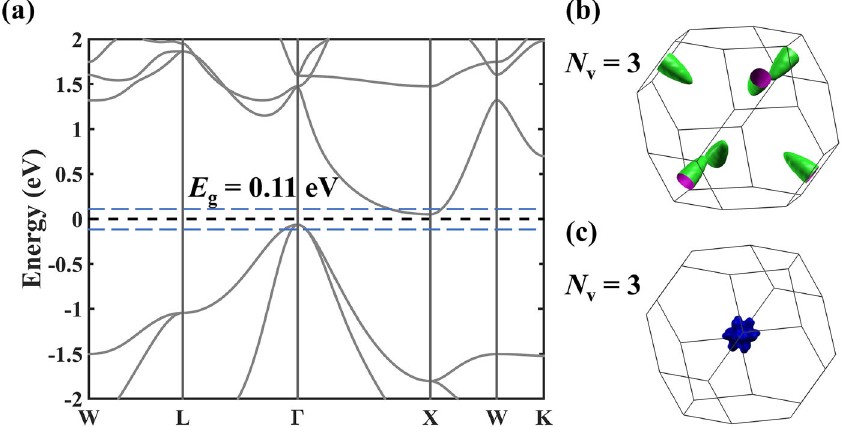
Fig. 6 Calculated band structure and iso-energy surfaces of ScNiSb, respectively. a Band structure and iso-energy surfaces of b n-type and c p-type ScNiSb at the Fermi level 0.1 eV above conduction band minimum and below valence band maximum,